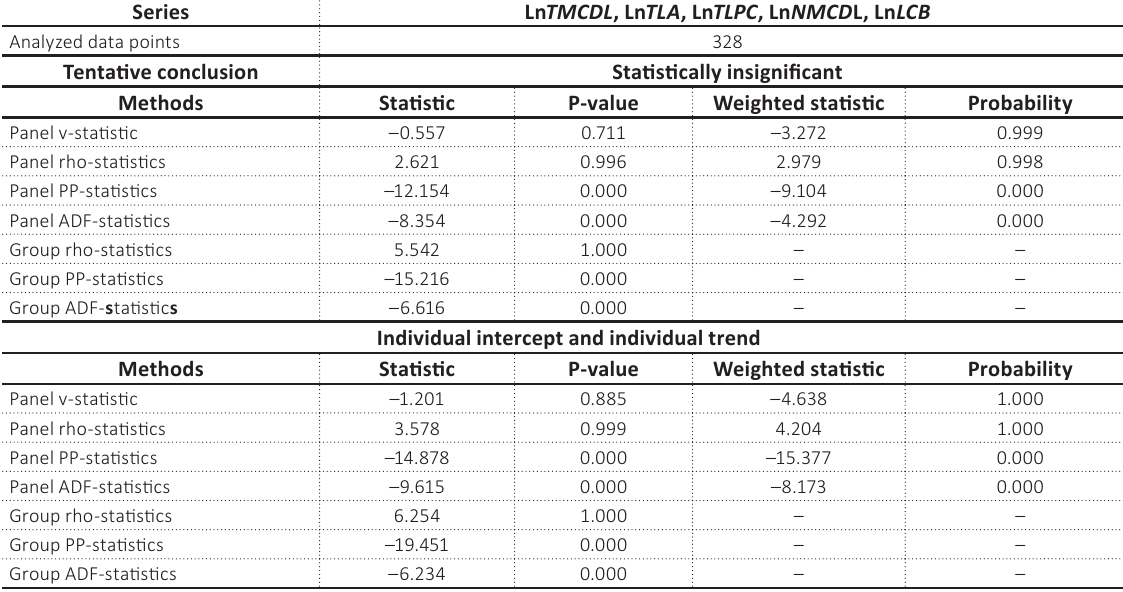
Table 6. Products of Pedroni (E-G-based)